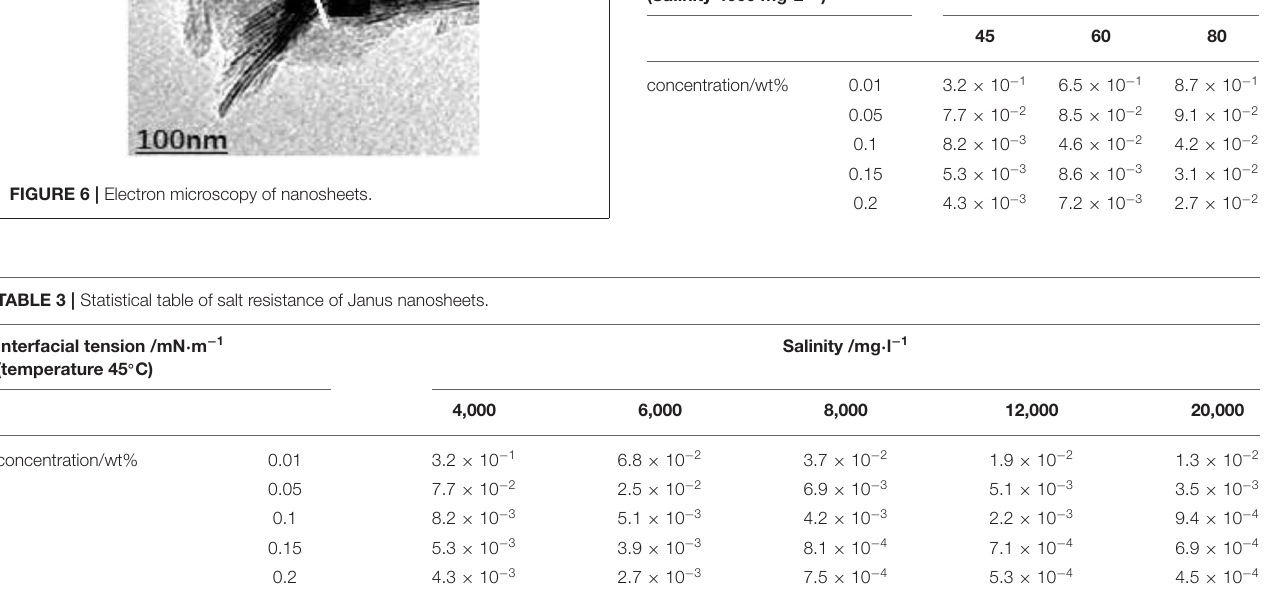
Frontiers in Chemistry |